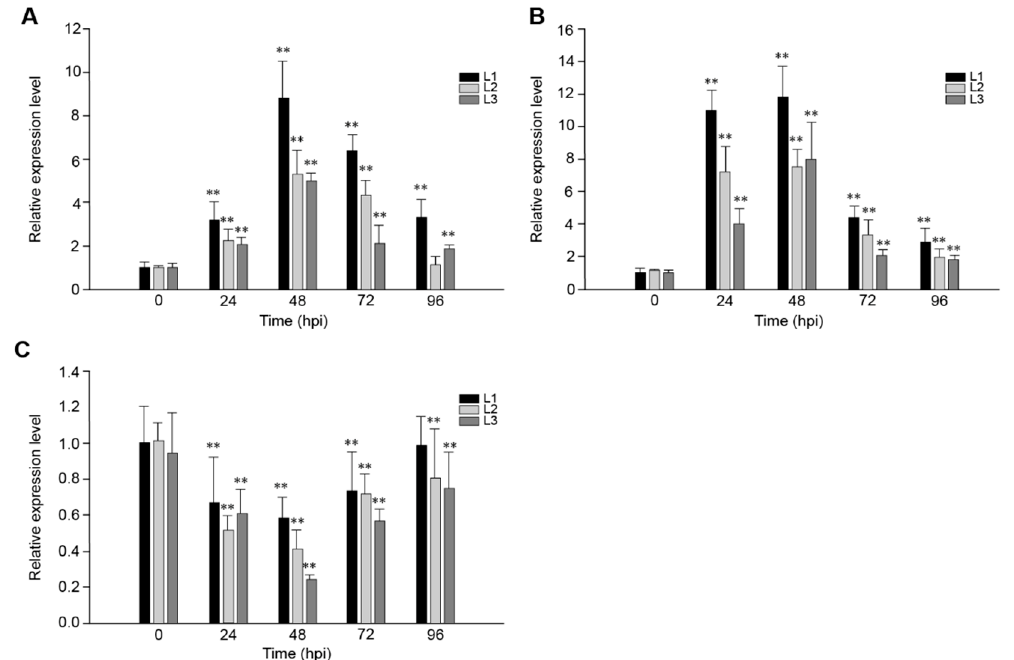
Figure 2. VaRGA1 expression level in transgenic Arabidopsis following ( A ) Hpa infection, ( B ) Pst DC3000 infection, and ( C ) B. cinerea infection. VaRGA1 expression level in transgenic Arabidopsis line 1 (L1) under non-stressed conditions was defined as 1.0. Data represent mean values ± SD from three independent experiments. Asterisks show statistically significant differences (** p < 0.01, Student’s t test).